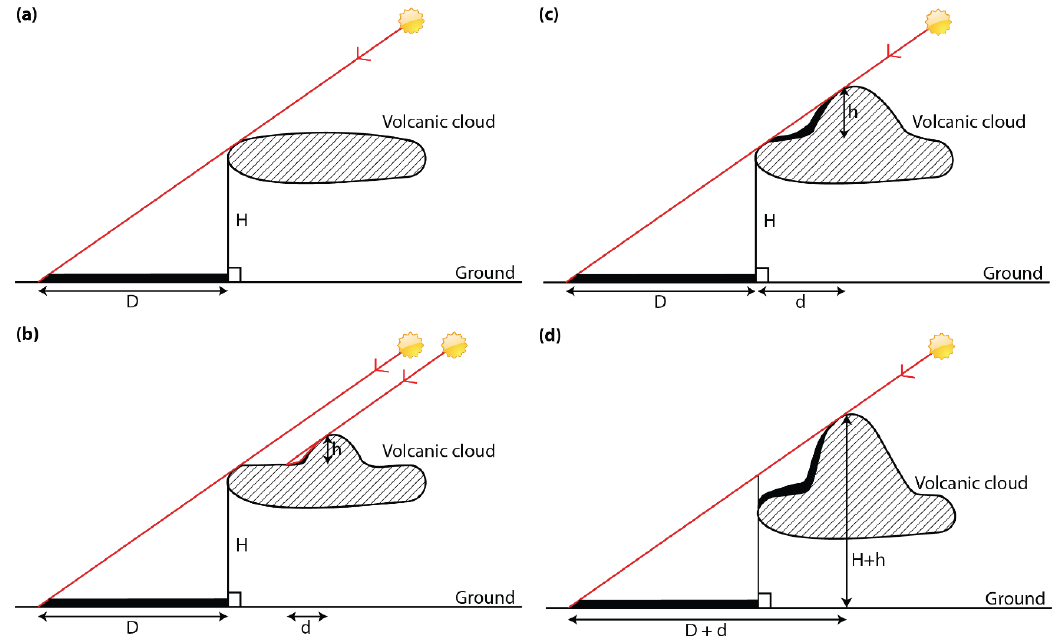
Figure 4. Plume / cloud height measurement at nadir case depending on the shadow distribution. ( a ) Case i: flat plume. ( b ) Case ii: plume with topography where measurement of H and h is possible. ( c ) Case iii: plume with topography where measurement of H and h is possible. ( d ) Case iv: intermediate